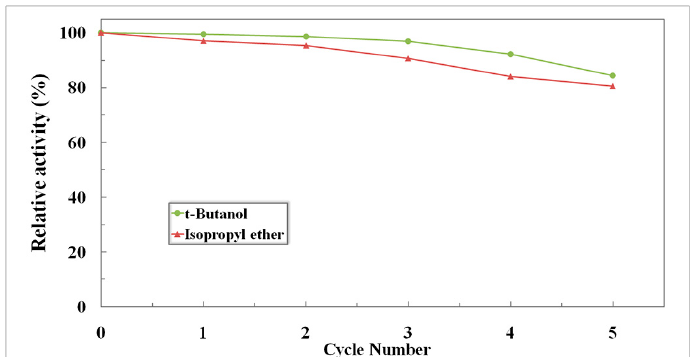
Figure 12. Reuse of AOT-activated magnetic RML CLEAs for biodiesel production from jatropha oil in isopropyl ether and tert-butanol.